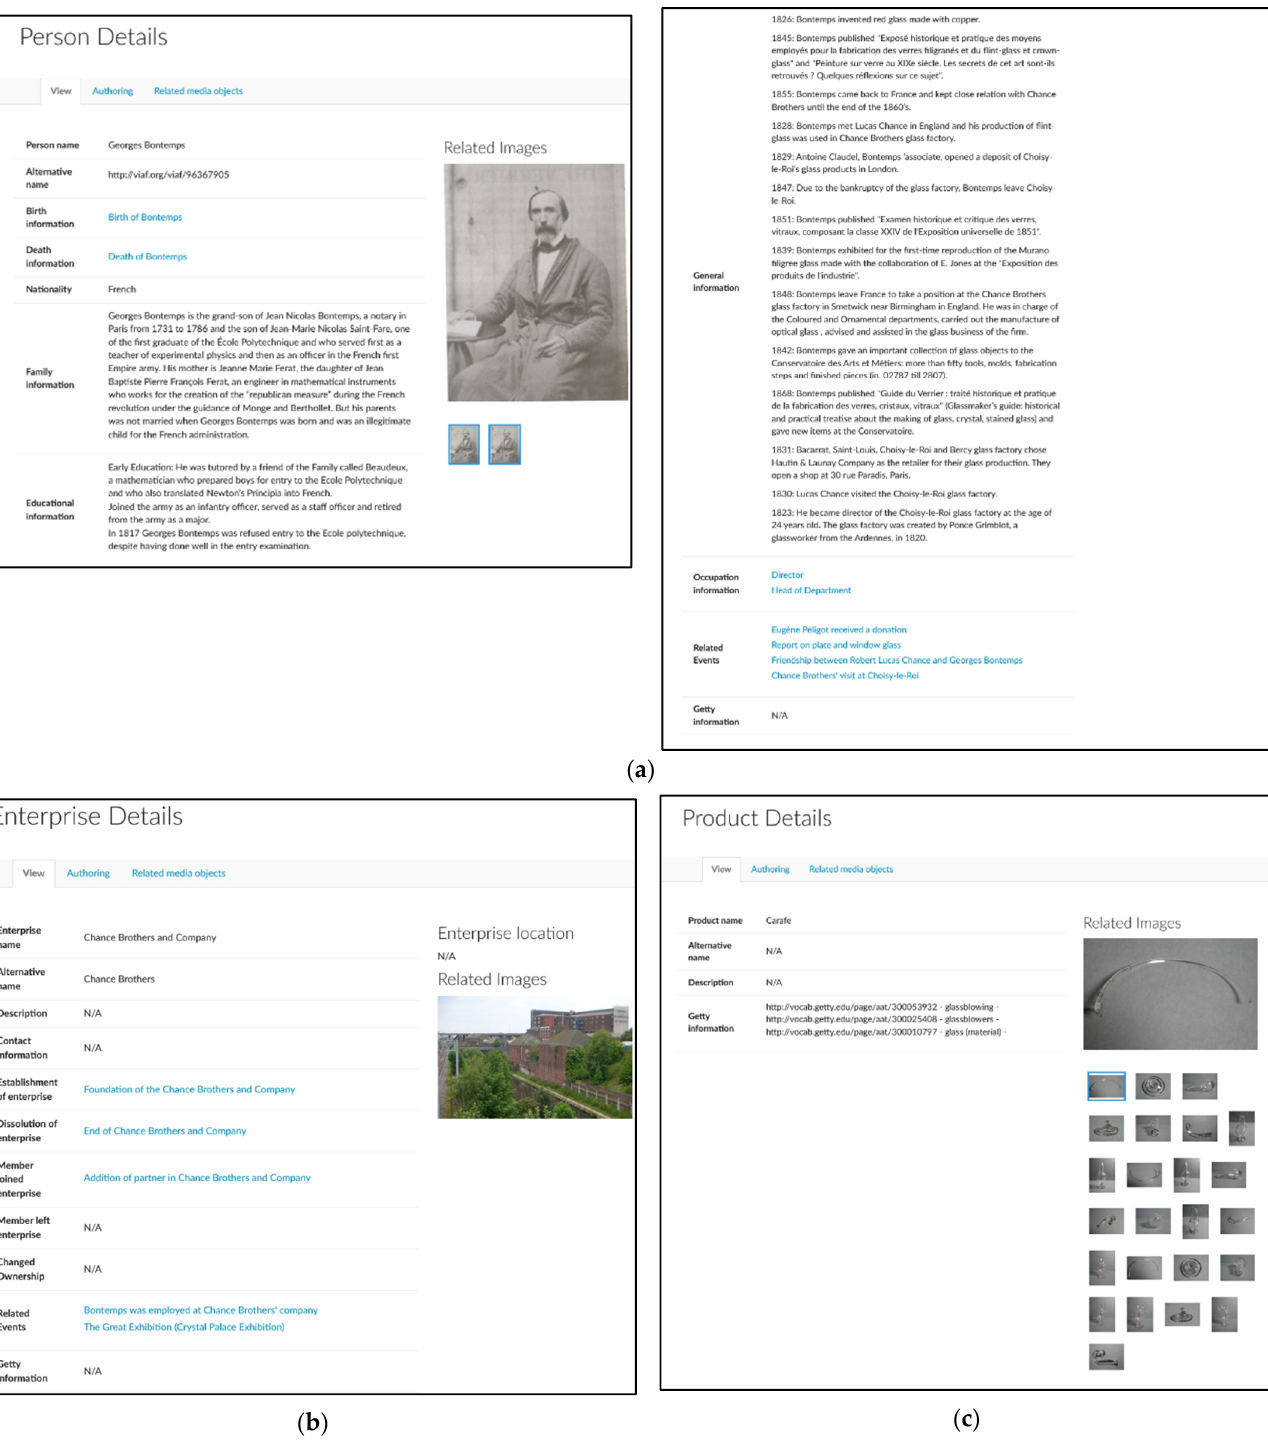
Figure 3. Documentation examples ( a ) Person, ( b ) Enterprise, ( c ) Product.